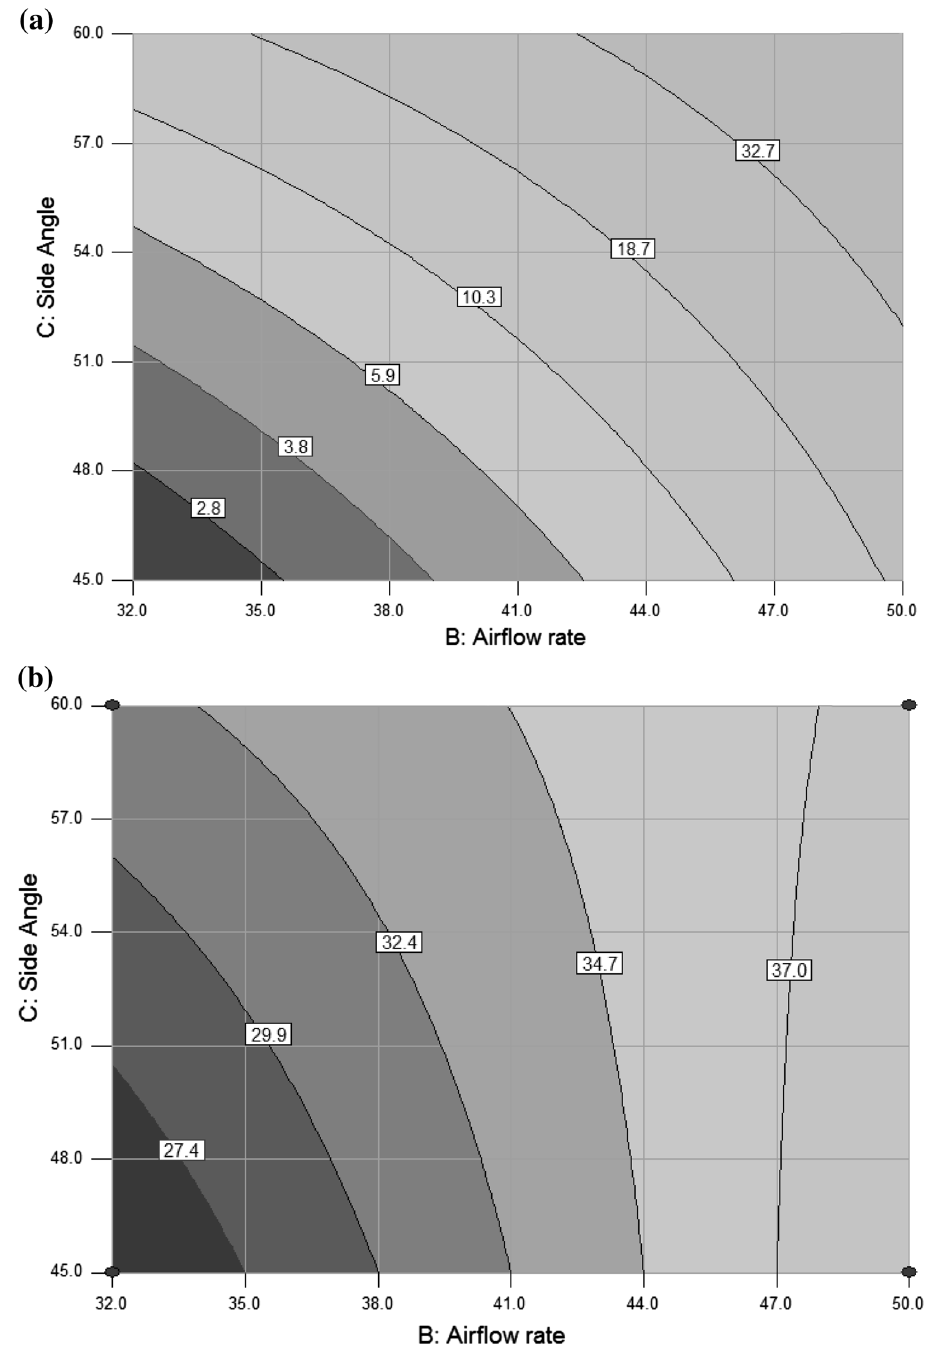
Fig. 9 Interaction effect of Transverse angle and Airflow rate on ash of clean coal at 21